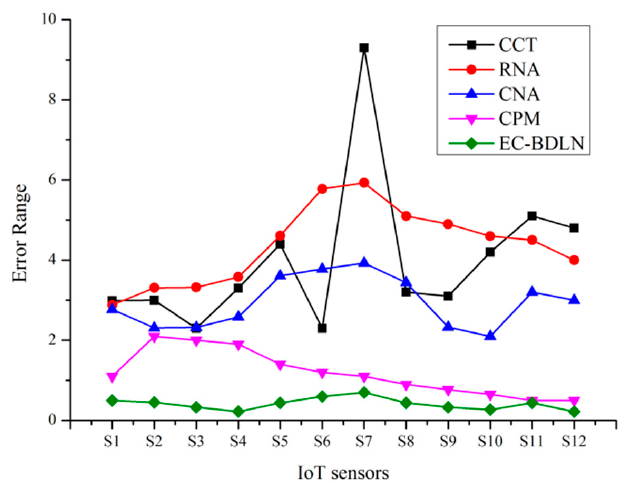
Figure 7. Mean residual error estimation analysis for the smart log patch.